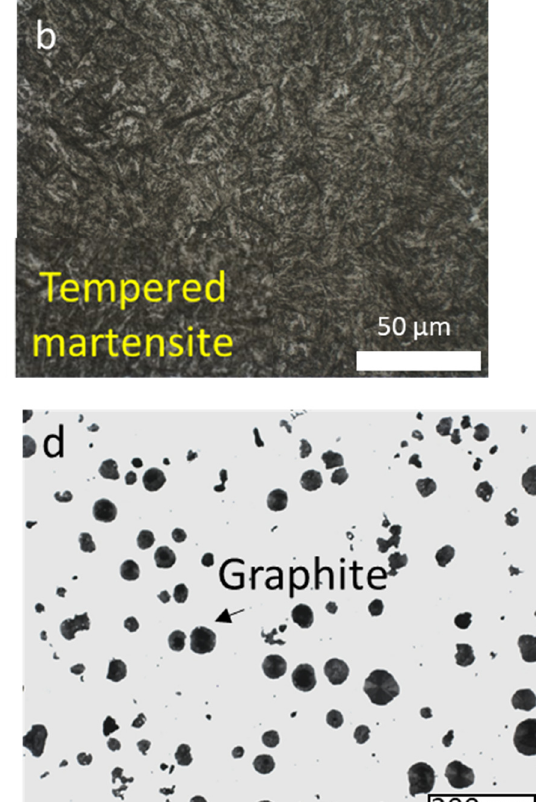
Table 3. Chemical composition (wt%) and hardness (HRC) measured on the tool material samples.